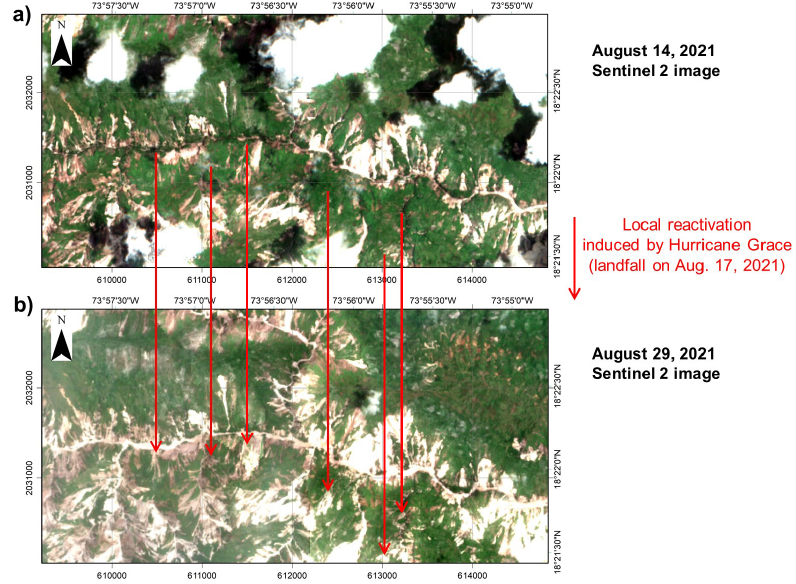
Figure A3. Comparison between Sentinel-2 images (10m resolution) for the same area obtained for (a) 14 August (about 2h after the main shock) and for (b) 28 August 2021 (12d after impact by Hurricane Grace that crossed the region on 16 August 2021). Red arrows point to zones where an intensification of denudation and sliding can be observed.